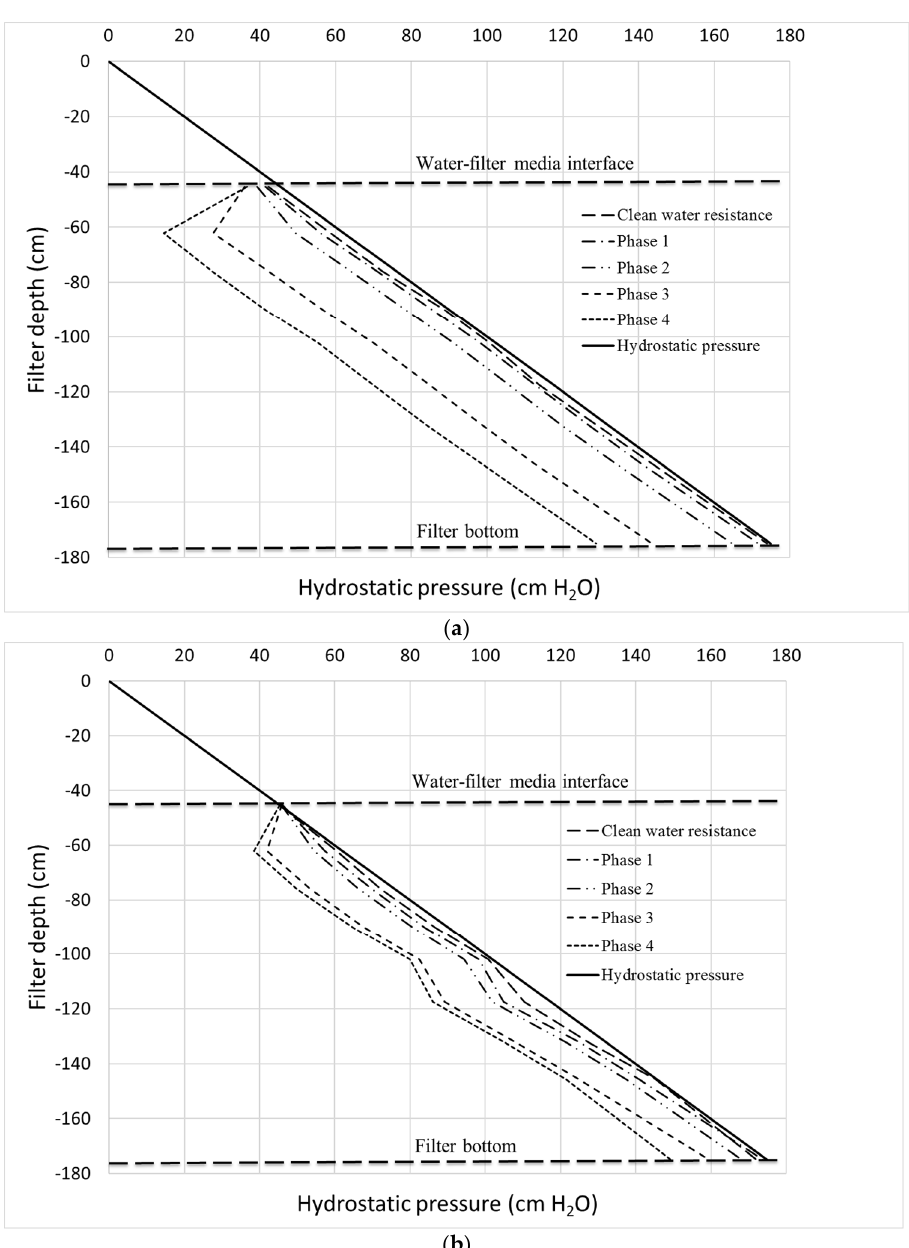
Figure 7. Headloss development at different phases of filtration test for ( a ) Column 1 and ( b ) Column 2.